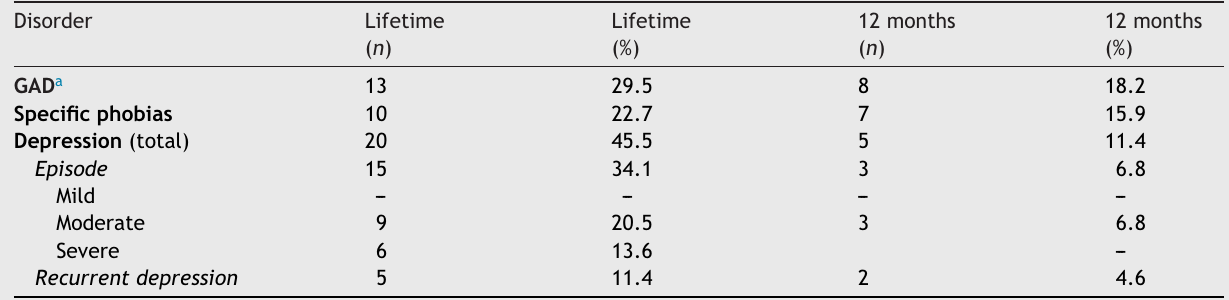
Table 1 Prevalence of anxiety and depressive disorders, according to ICD-10, in elderly patients with chronic dizziness of vestibular origin ( n =